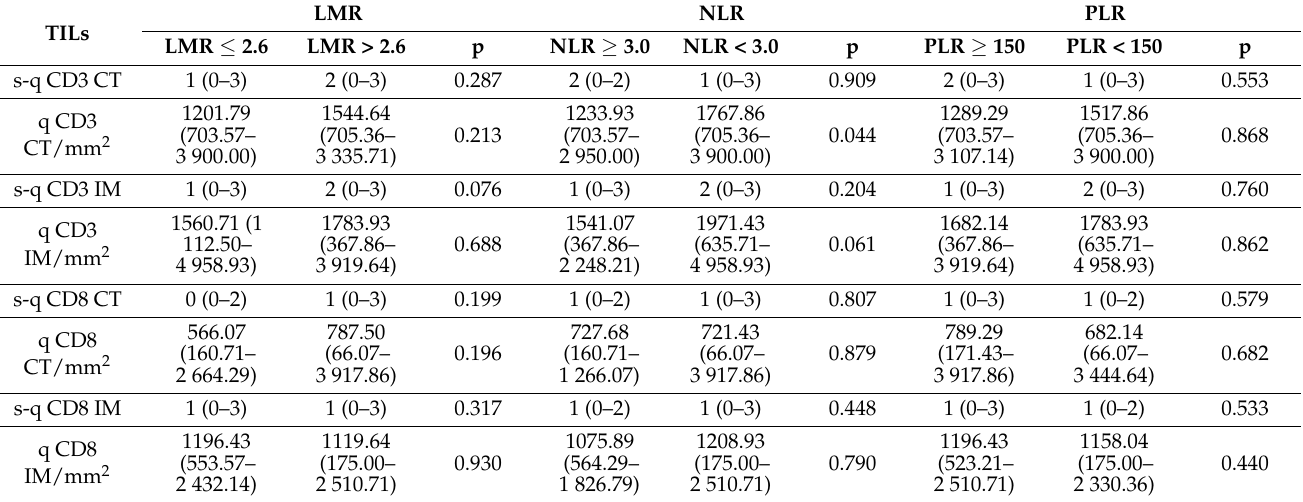
Table 5. Comparison of TILs according to pre-treatment values of SIR